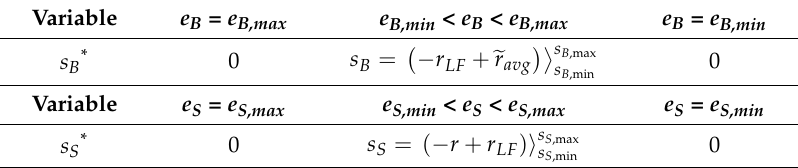
Table 4. Frequency-based management